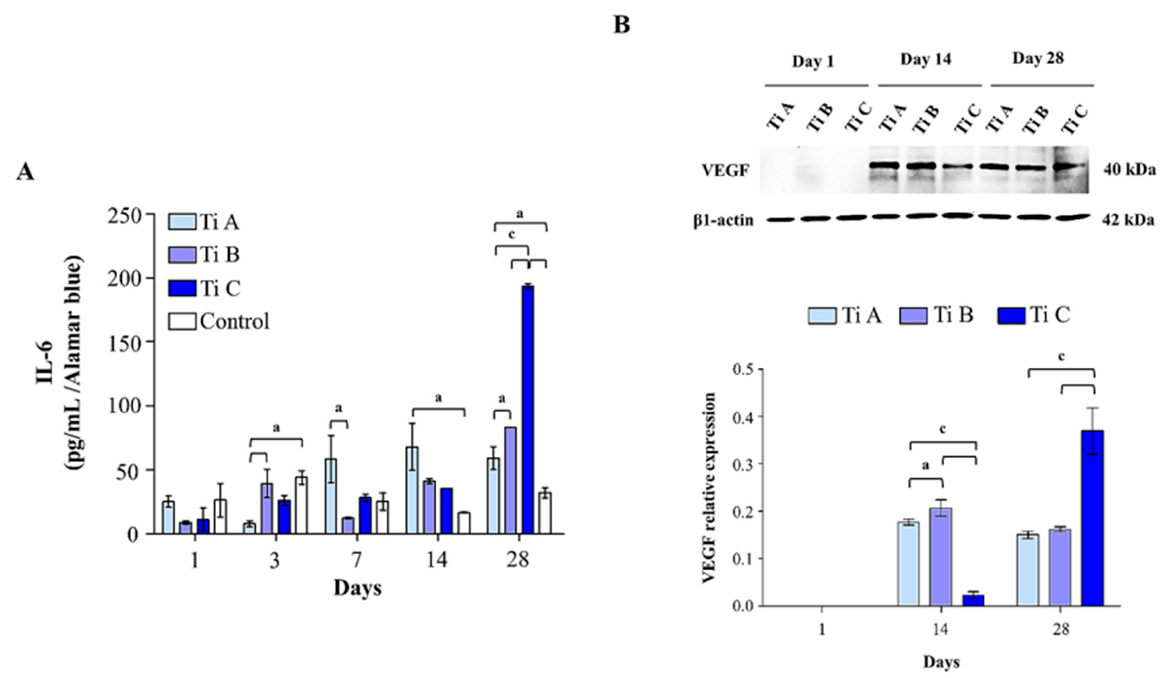
Figure 7. ( A ) ELISA assay for IL-6 secretion of DPSCs cultured on Titanium A, B, C and coverslip scaffold (control) for 1, 3, 7, 14, and 28 days. Secretion levels are reported as µ g per milliliter per alamarBlue values. The results are the mean ± SD of three samples from three different experiments. ( B) VEGF expression in DPSCs cultured on Titanium A, B and C for 1, 14 and 28 days. Each membrane has been probed with β 1–actin antibody to verify loading consistency. Western blot is the most representative of three different experiments. Histograms represent densitometric measurements of proteins bands expressed as integrated optical intensity (IOI) mean of three separate experiments. The error bars show standard deviation ( ± SD). a = p < 0.01; b = p < 0.001; c = p < 0.0001.